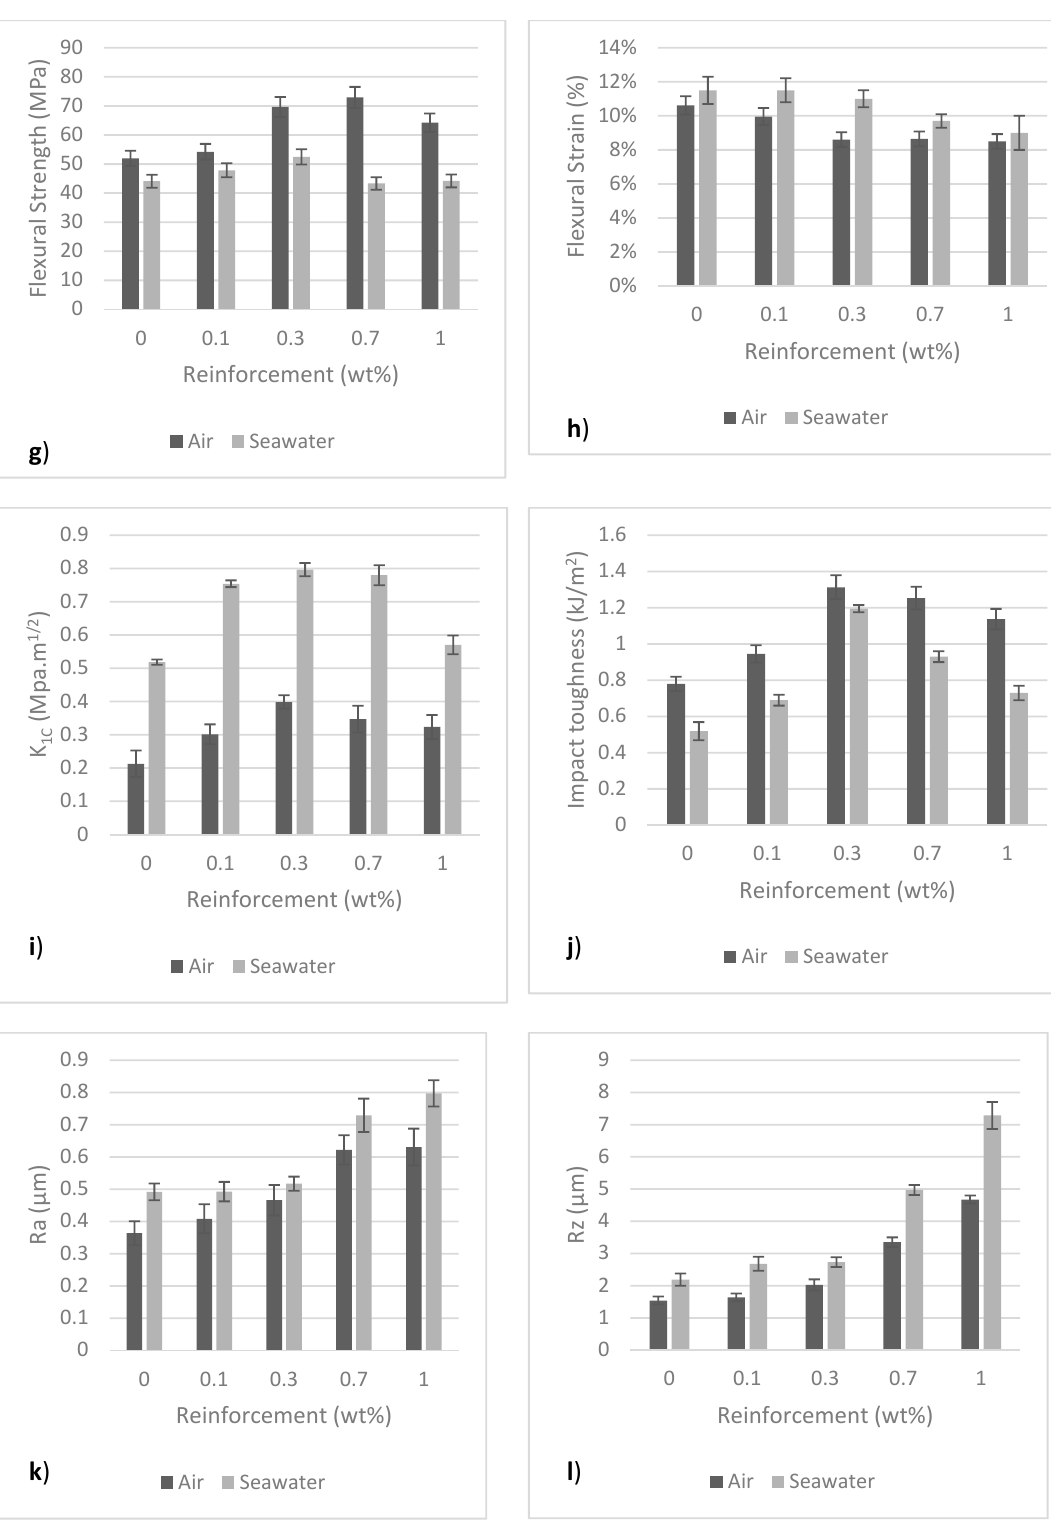
Figure 5 . Mechanical properties of nanocomposites; ( a ) seawater absorption; ( b ) light transmission; ( c ) Young’s modulus; ( d ) tensile strength; ( e ) tensile strain ( f ) flexural modulus; ( g ) flexural strength; ( h ) flexural strain; ( i ) fracture toughness; ( j ) impact toughness; ( k ) Ra; and ( l ) Rz.